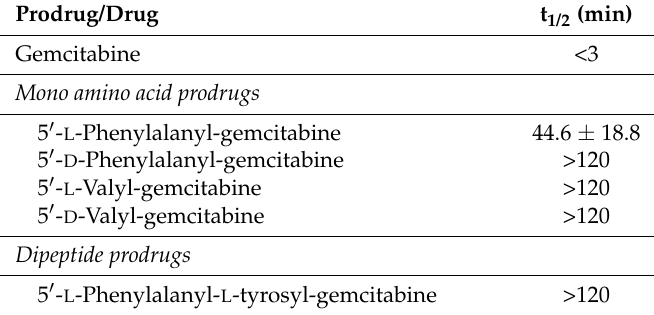
Table 3. Stability of gemcitabine and gemcitabine prodrugs in the presence of cytidine deaminase (mean ± S.D., n = 3).